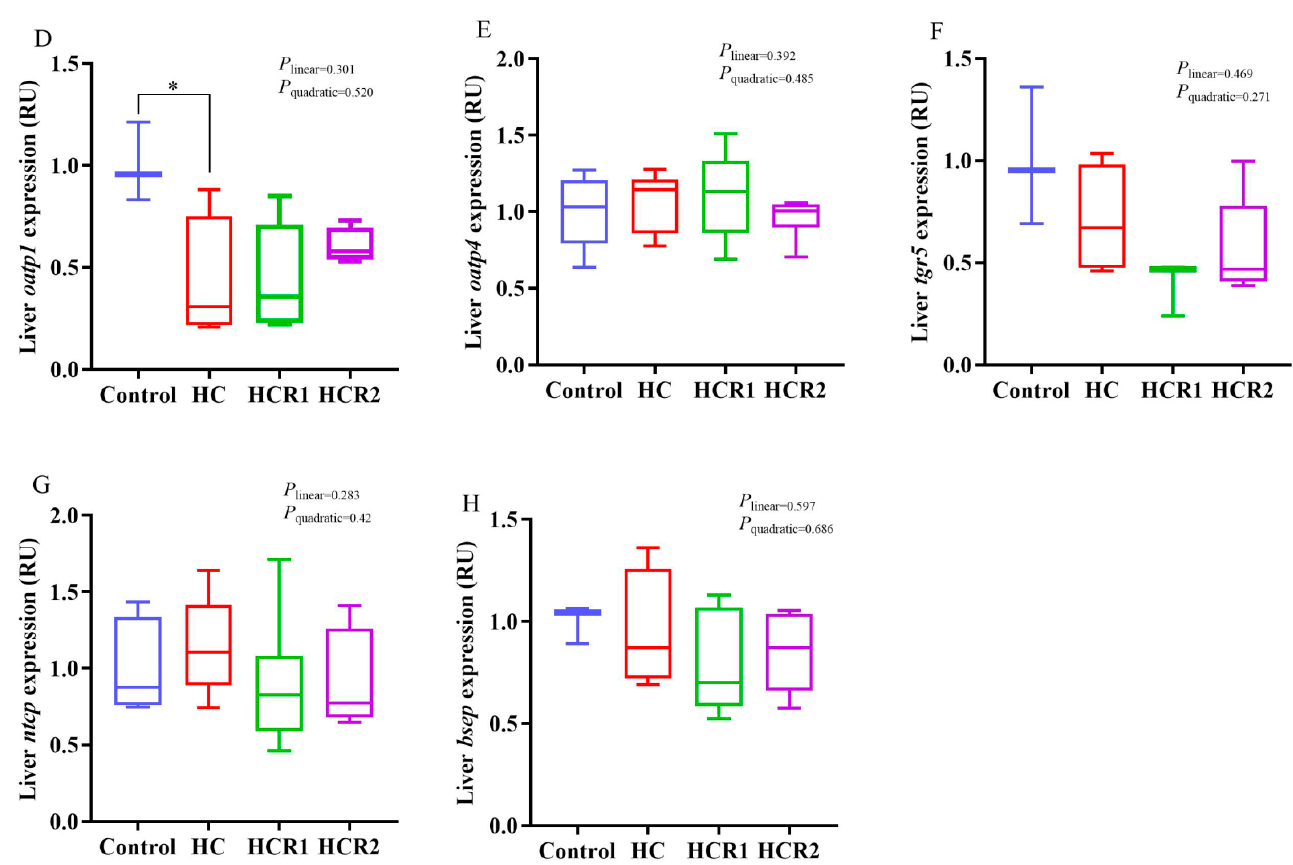
Figure 6. Hepatic transcriptions of the genes involved in bile acid metabolism. The mRNA levels of cholesterol 7 α -hydroxylase ( cyp7a1 ) ( A ), sterol 12 α -hydroxylase ( cyp8b1 ) ( B ), multidrug resistance associated protein 2 ( mrp2 ) ( C ), organic anion-transporting polypeptide 1 ( oatp1 ) ( D ), organic anion-transporting polypeptide 4 ( oatp4 ) ( E ), takeda G-protein-coupled BA receptor ( tgr5 ) ( F ), Na + -taurocholate cotransporter ( ntcp ) ( G ), bile salt export pump ( bsep ) ( H ) were evaluated using real-time RT-PCR. Data are referred to the values (relative units, RU) obtained in fish fed the control diet. Each data point represents the mean of four replicates (4 individuals per replicate). * Means p < 0.05, compared between the control and the HC group. ab Compared among the HC, HCR1, and HCR2 groups. Bars assigned with different superscripts are significantly different ( p < 0.05). The first and third quartiles are represented by the top and bottom of the box, while the minimum and maximum values are represented by the whiskers. Control, diet with 32% nitrogen-free extract; HC, diet with 45% nitrogen-free extract; HCR1, diet with 45% nitrogen-free extract and 0.04% resveratrol; HCR2, diet with 45% nitrogen-free extract and 0.08% resveratrol. As presented in Figure 7, the transcriptions of fxr α , lxr α , and mrp2 in the HC group were all remarkably ( p < 0.05) higher than those in the control group in the hindgut. However, they all decreased both linearly and quadratically ( p < 0.05) with increasing dietary resveratrol levels. The transcription of tgr5 in the control group was remarkably ( p < 0.05) higher than that in the HC group. In addition, the transcriptions of oatp4 and oatp1 in the HC group both exerted no statistical difference ( p > 0.05) compared with the control group. However, they decreased both linearly and quadratically ( p < 0.05) with increasing dietary supplementation